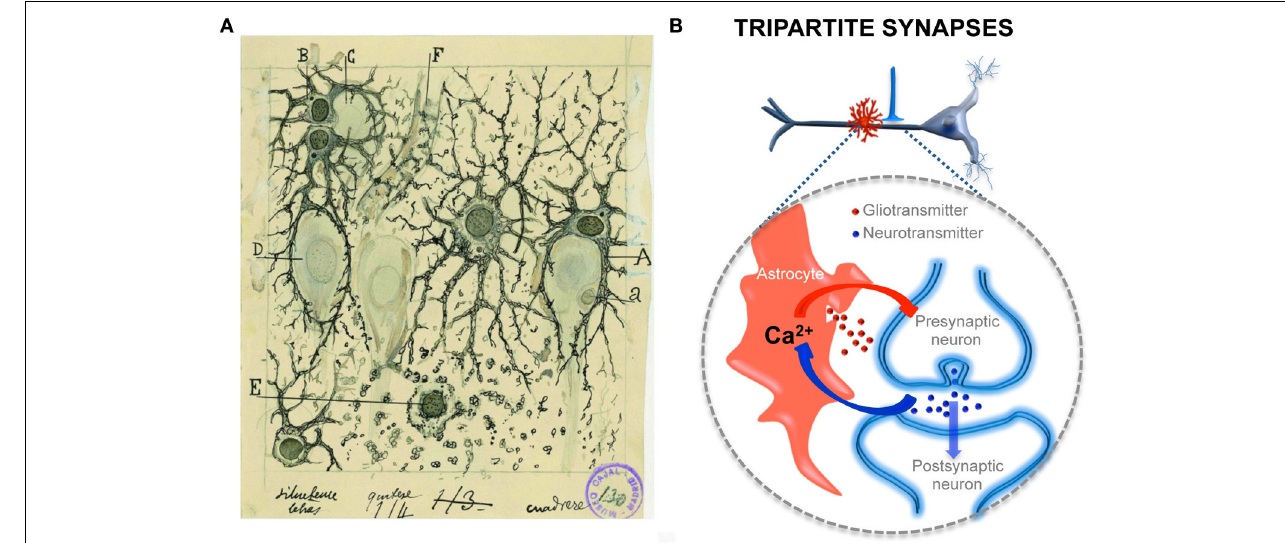
FIGURE 2 | Structural and functional relationships of neurons and astrocytes and tripartite synapses. (A) Cajal’s drawing showing “neuroglia” of the pyramidal layer and stratum radiatum of the Ammon horn (from adult man autopsied 3h after death). Original labels: A, large astrocyte embracing a pyramidal neuron; B, twin astrocytes forming a nest around a cell, C, while one of them sends two branches forming another nest, D; E, cell with signs of “autolysis”; F, capillary vessel. Sublimated gold chloride method. Reproduced from an original drawing, with permission of the Instituto Cajal. (B) Scheme of one axon establishing a synapse on an apical dendrite of a